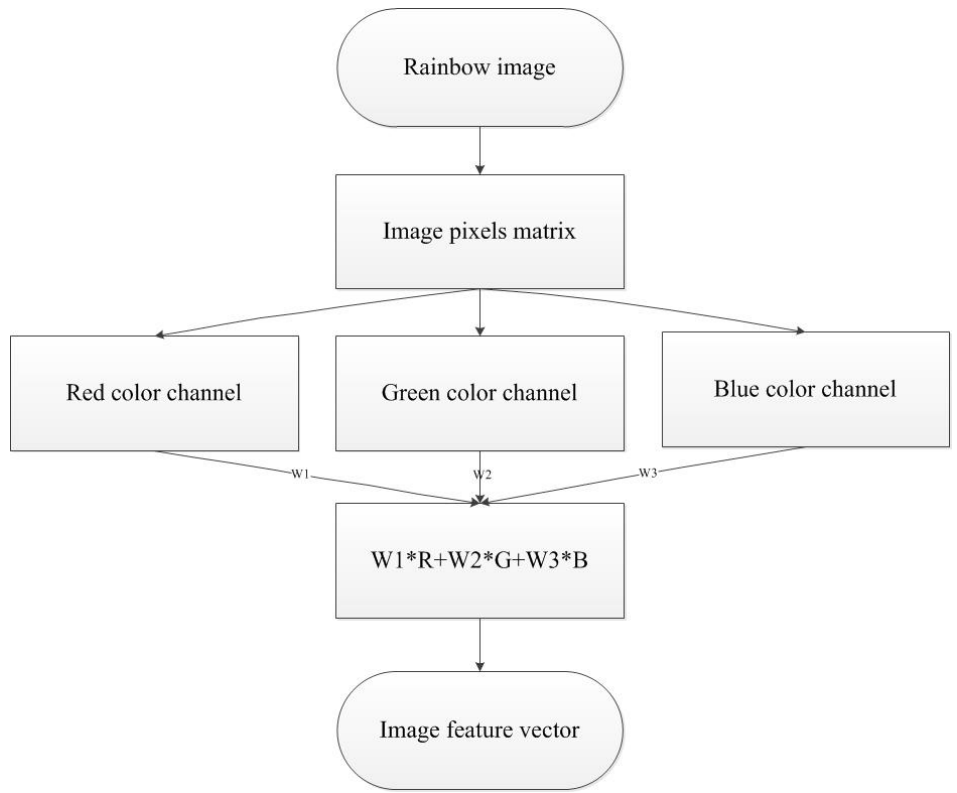
Figure 6. The framework of converting the rainbow image into the image feature vector in RGB color histogram.